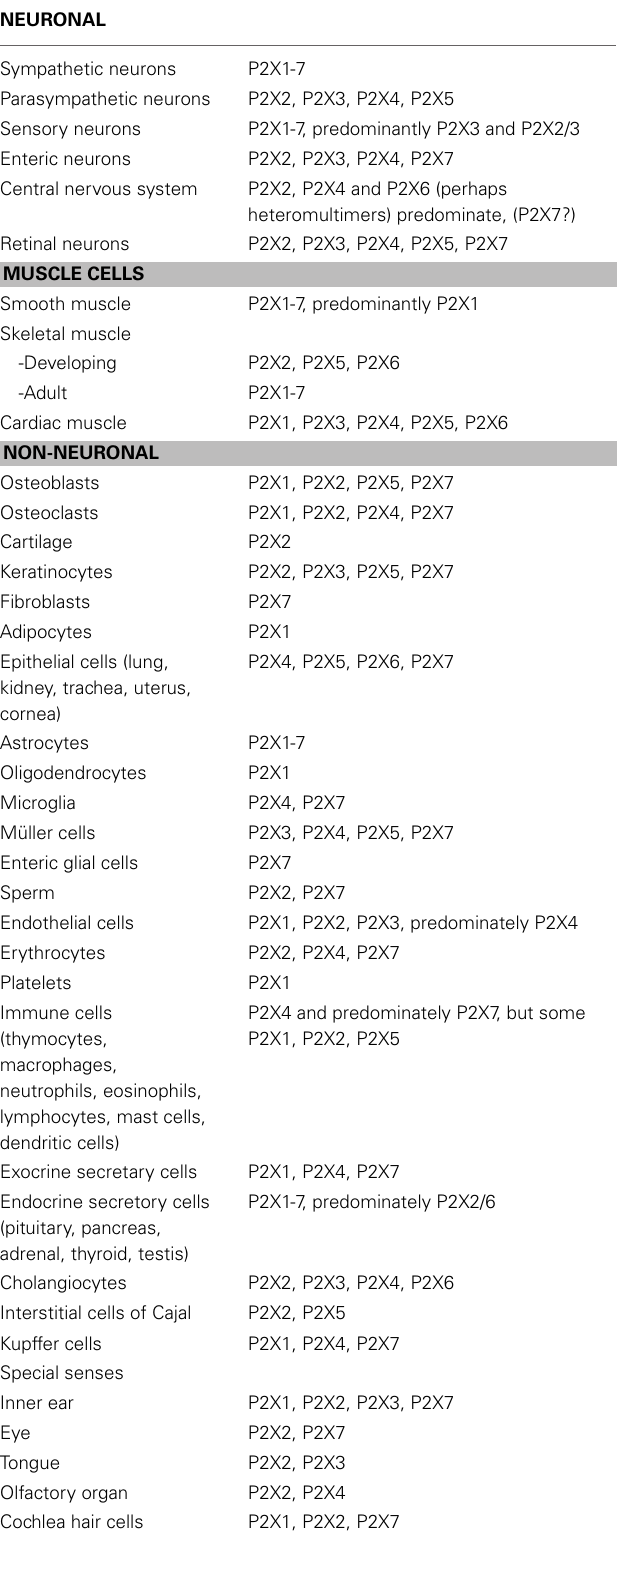
Table 1 | Principal P2X receptors expressed by excitable tissues and non-neuronal cells (Compiled from Burnstock,